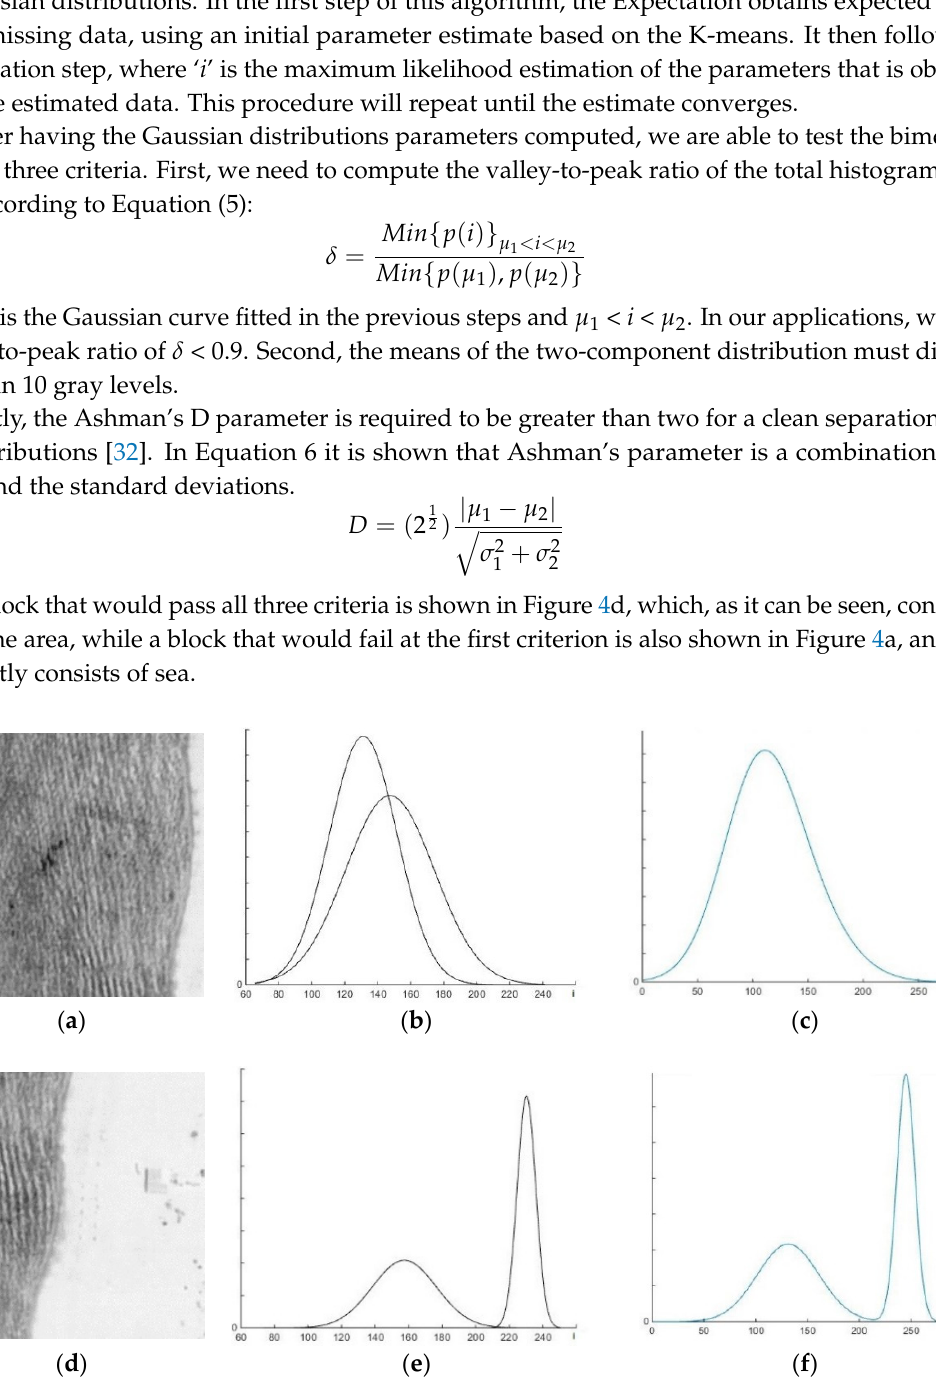
Figure 4. Blocks reflecting various cases of the bimodality procedure: ( a ) A block that contains mostly sea area, ( d ) a block that contains coastline area, ( b , e ) presents the two Gaussian distributions modelling the distribution of the first and the second image, respectively, ( c , f ) reflects the extracted mixture of the two Gaussian distributions for images ( a , d ), respectively.